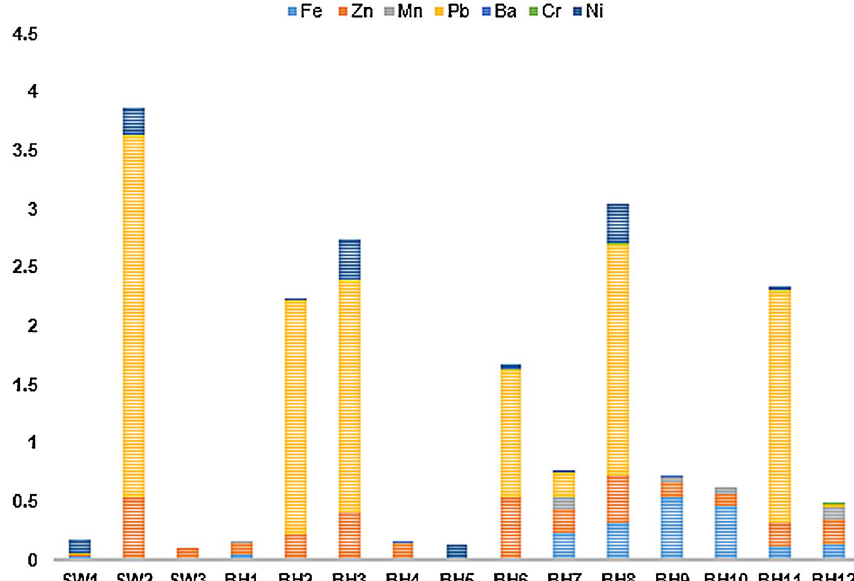
Fig. 12 Heavy metal concentra- tions (distribution) in the water